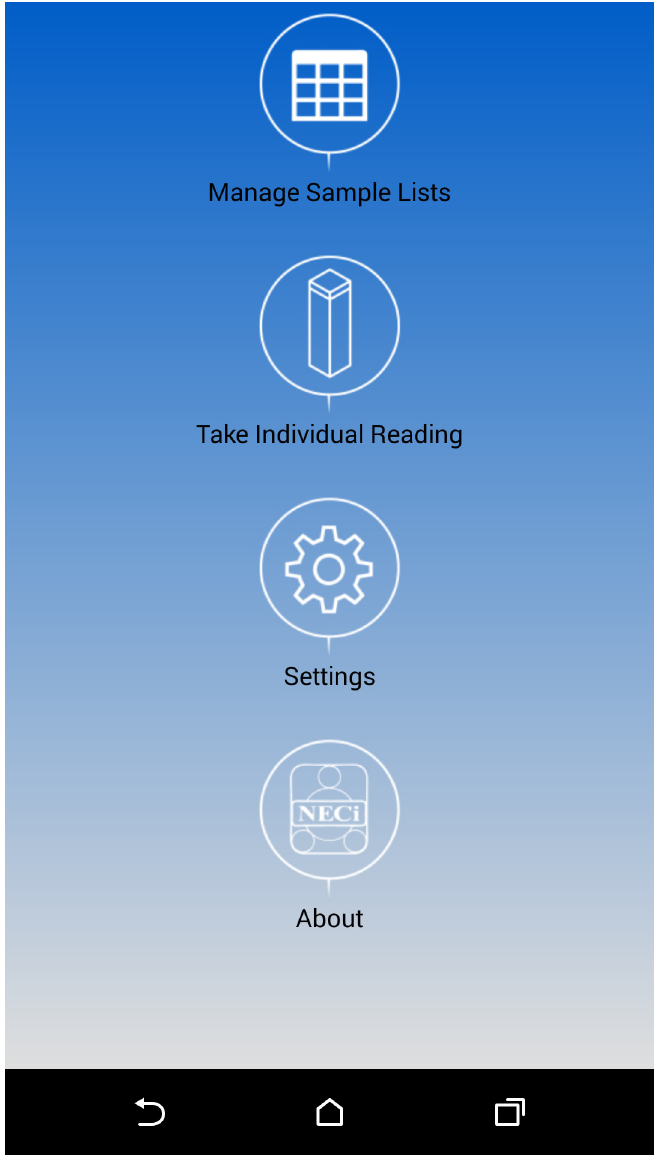
Fig 9. Screenshot of Android phone App interface for the Home